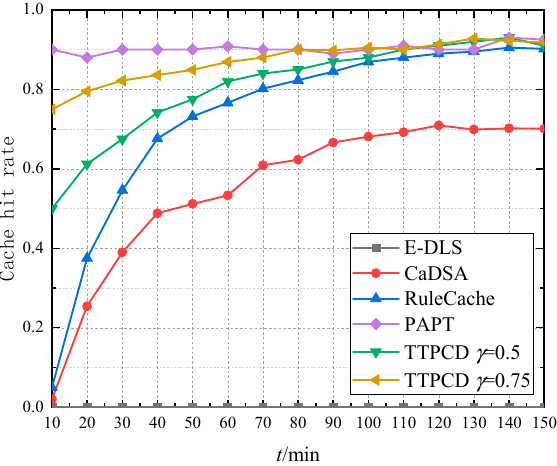
Figure 11. The cache hit